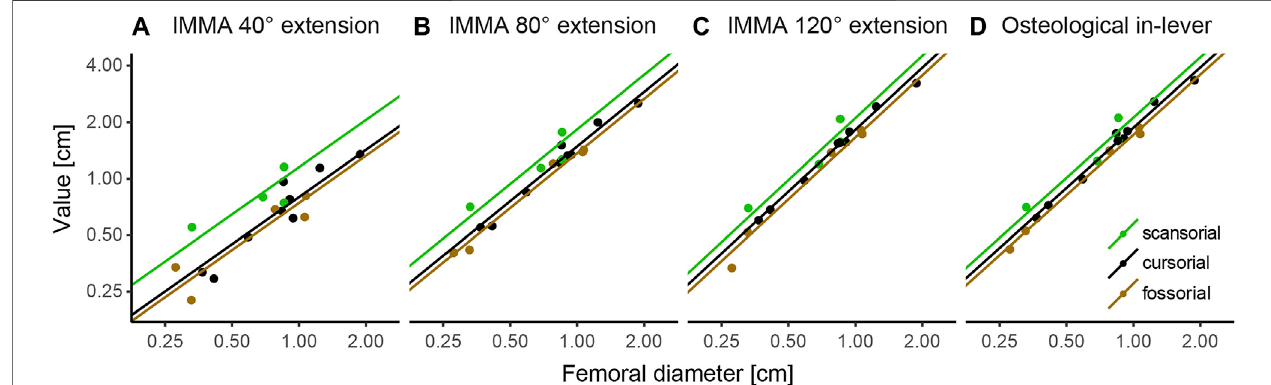
FIGURE5| Regressionplotsofinstantaneousmusclemomentarms(IMMAs)andosteologicalin-levervs.femoraldiameter.IMMAsweretakenfromthreedifferent extensionangles (A – C) at30 ° abduction. (D) Osteologicalin-lever.Linesindicatetheregressionslopeswithvaryingintercepts(i.e.,theprimaryoptimaforagivenfemoral diameter) among lifestyle categories as estimated by the most likely macroevolutionary model ( Table 1 ). The coordinate axes were log-transformed.